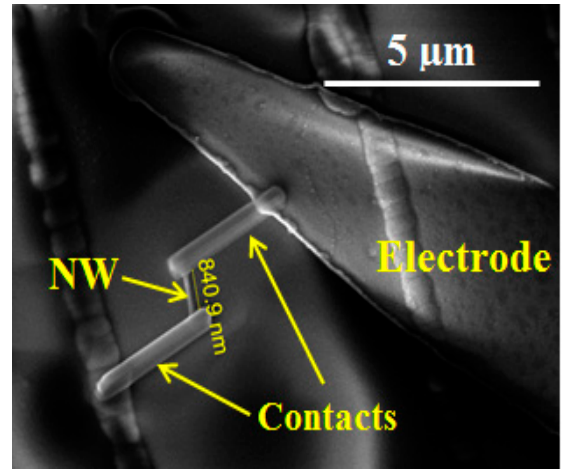
Figure 9. SEM image of the active region of the sensor, where a single NW is placed in contact with the electrode arms deposited onto the upper surface of the micro-hotplate.